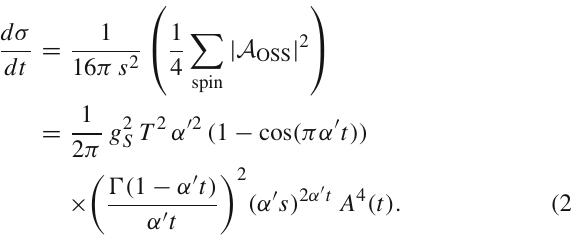
Fig. 1 A log-linear plot of the differential cross section at GeVfromtheE-710collaboration,asafunctionof − t (inGeV 2 ).Dotted line is the experimental data. Red line is Eq. (21) with g S = 88 . 316, √ α (cid:3) = 1 . 351 GeV, (cid:11) = 6 . 570 GeV and input parameters M S = 1 /